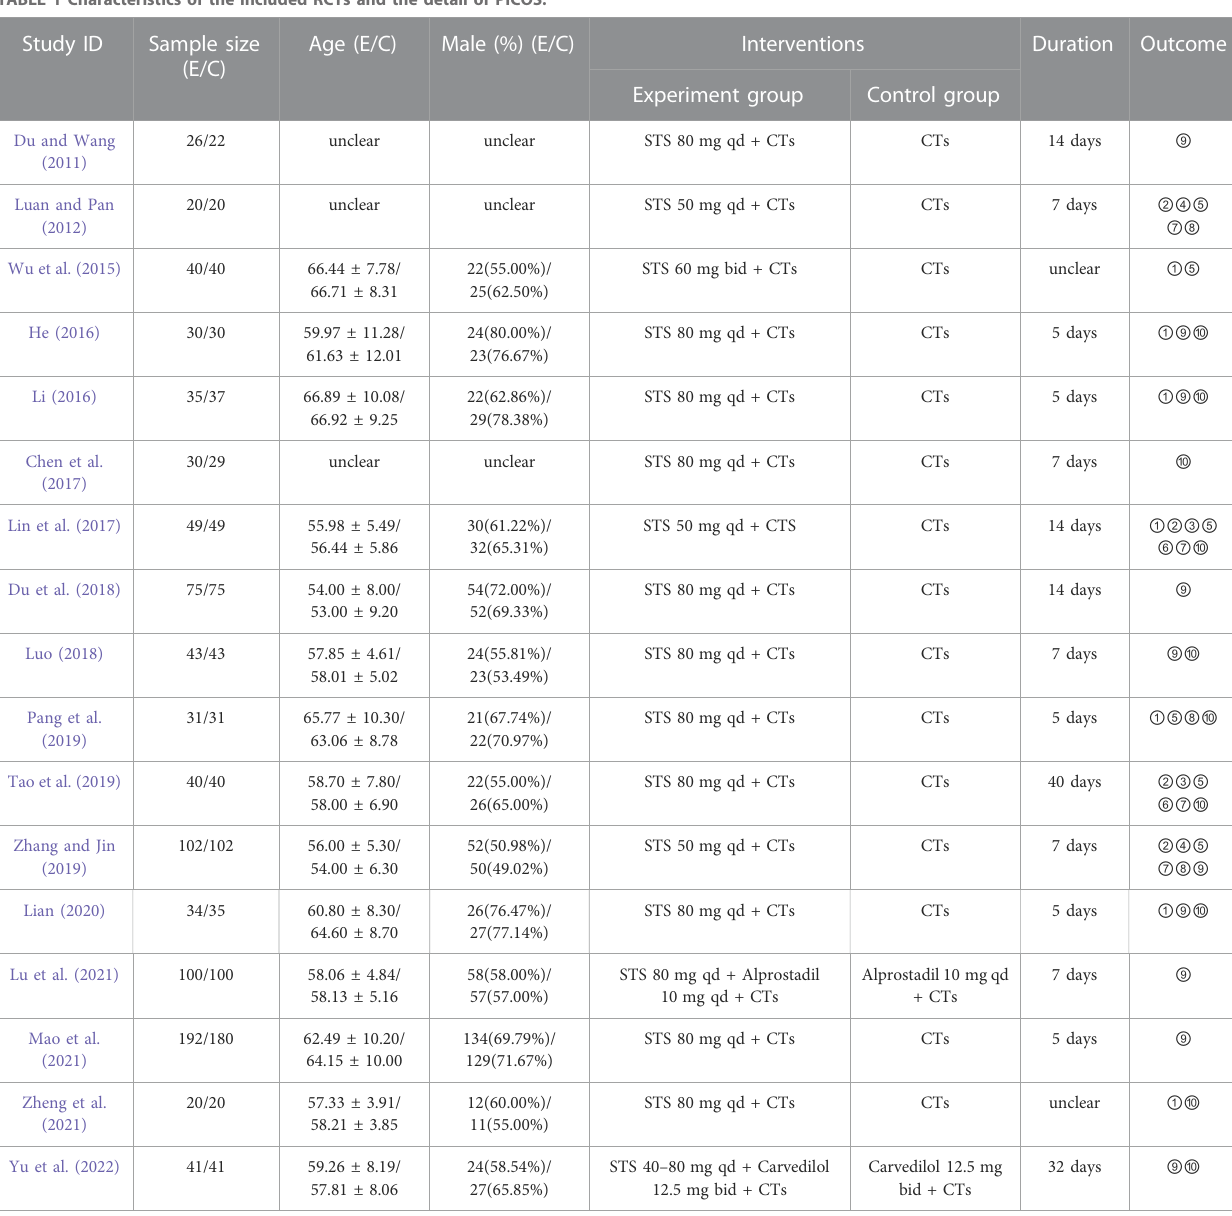
TABLE 1 Characteristics of the included RCTs and the detail of